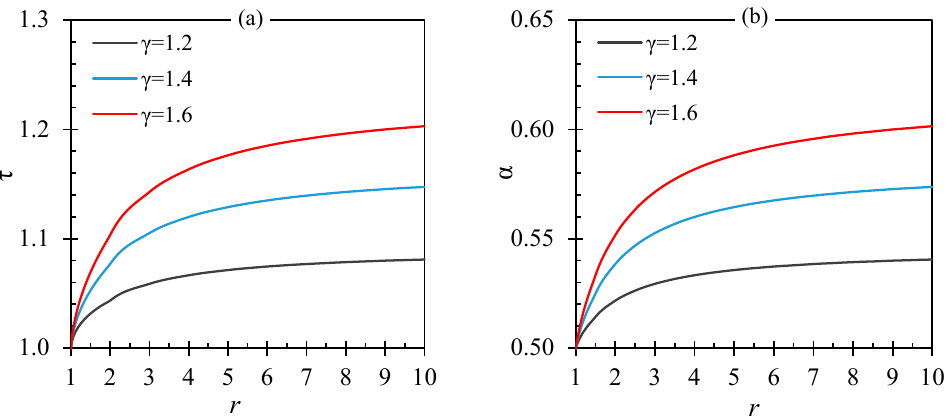
Figure 4. Dimensionless temperature of the driving gas at the end of the compression stroke ( a ) and relative efficiency ( b ) for different heat capacity ratios as a function of the relative work; 𝑟 = 3.